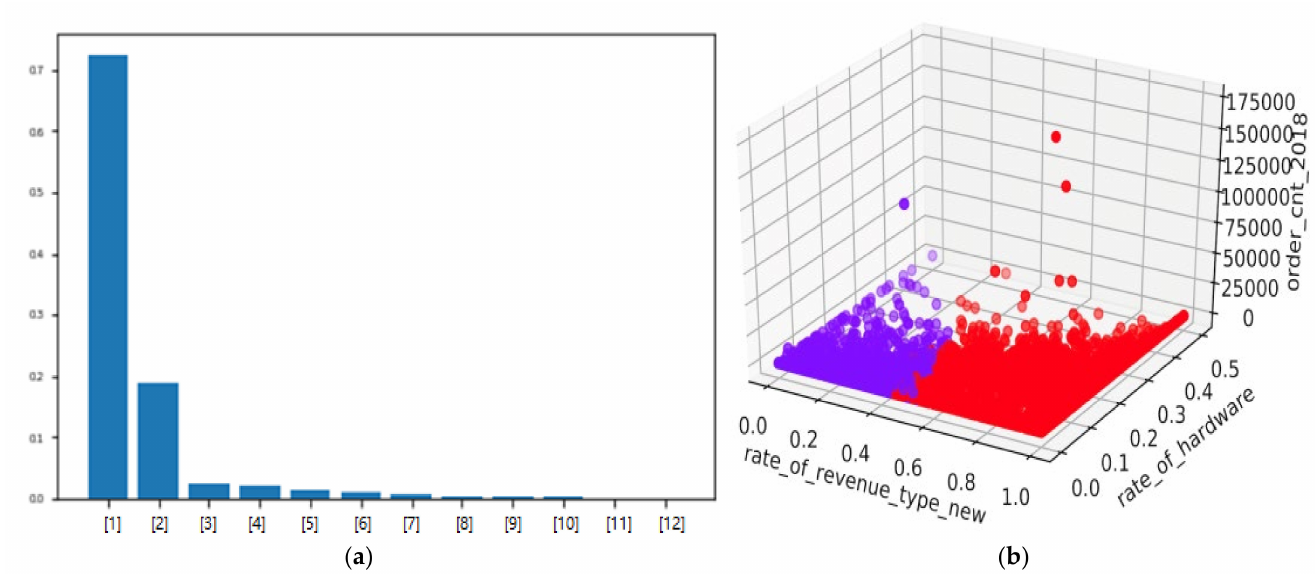
Figure 5. ( a ) Histogram of the important transformation dimensions(Notes: [1] stands for